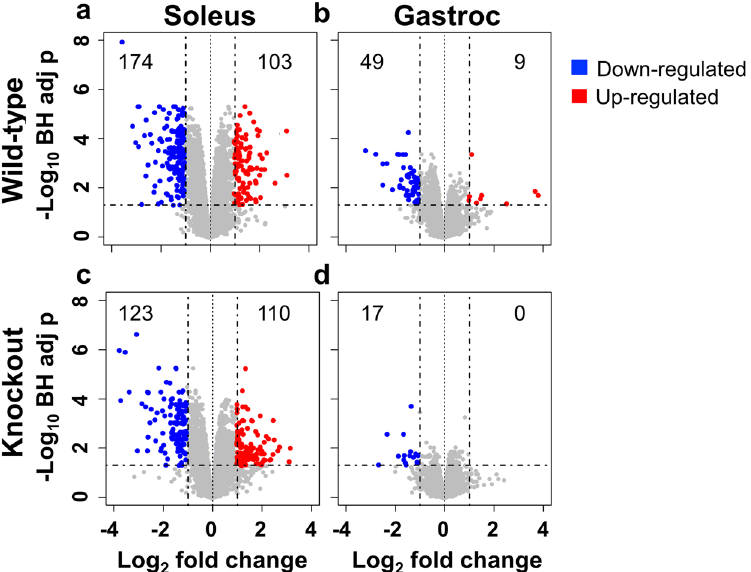
Figure 2. Volcano plots showing differentially regulated genes in soleus and gastrocnemius and wild-type and MuRF1 KO mice exposed to spaceflight or ground control conditions. ( a ) WT soleus shows more significant changes in gene expression than ( b ) WT gastrocnemius. MuRF1 KO is associated with less gene regulation in both ( c ) soleus and ( d ) gastrocnemius. The log 10 (BH adjusted p-values) were plotted against the log 2 (FC) in gene expression. Genes up-regulated by two-fold or more and with a BH corrected p-value < 0.05 are shown as red symbols, genes that were down-regulated by twofold or more and with a BH corrected p-value < 0.05 are shown with blue symbols. Gastroc, Gastrocnemius; BH, Benjamini–Hochberg; FC, fold-change.